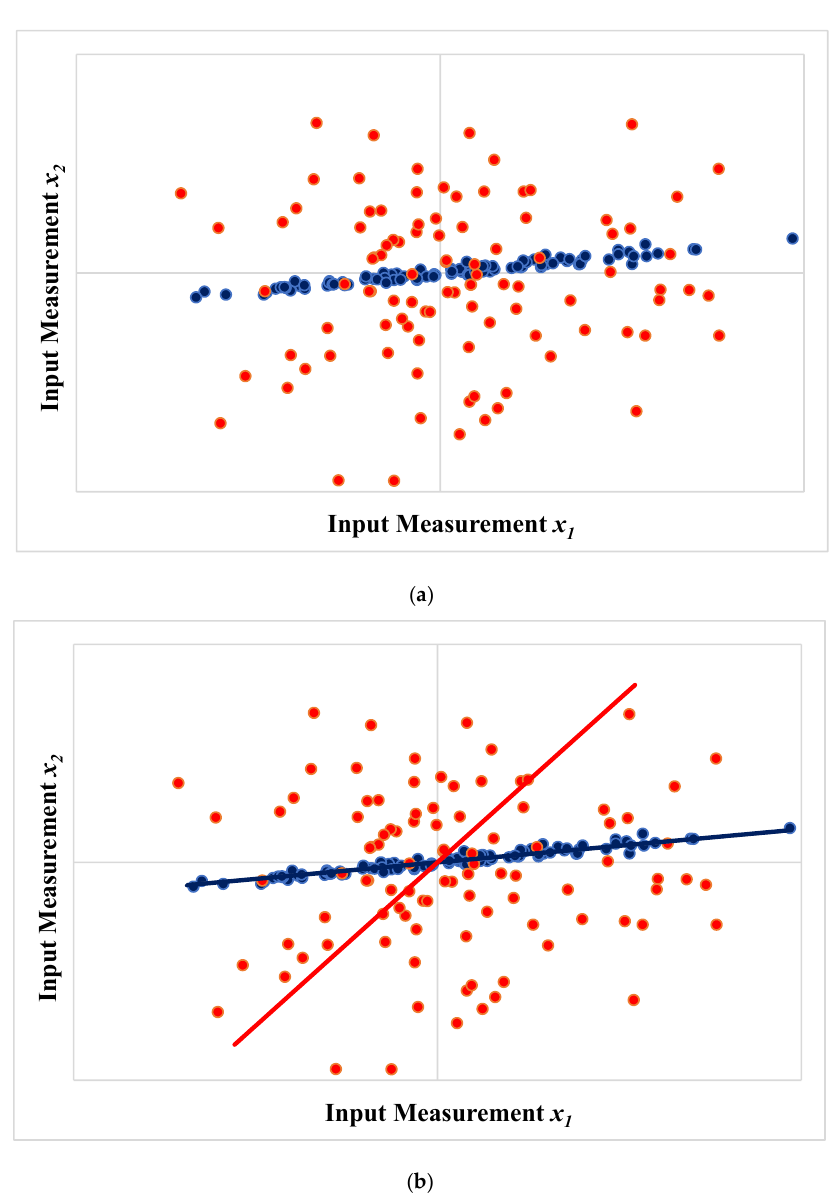
Figure 1. Effect of measurement fluctuations on the principal directions. ( a ) Datasets with different input populations. ( b ) Most influential principal directions calculated with standard PCA analysis (red) and the proposed H-PCR procedure (blue).